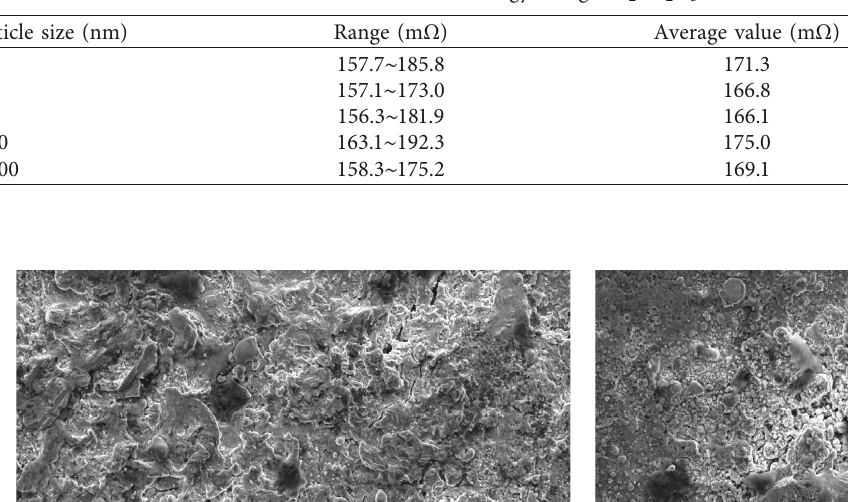
2 /La 2 O 3 contact material.